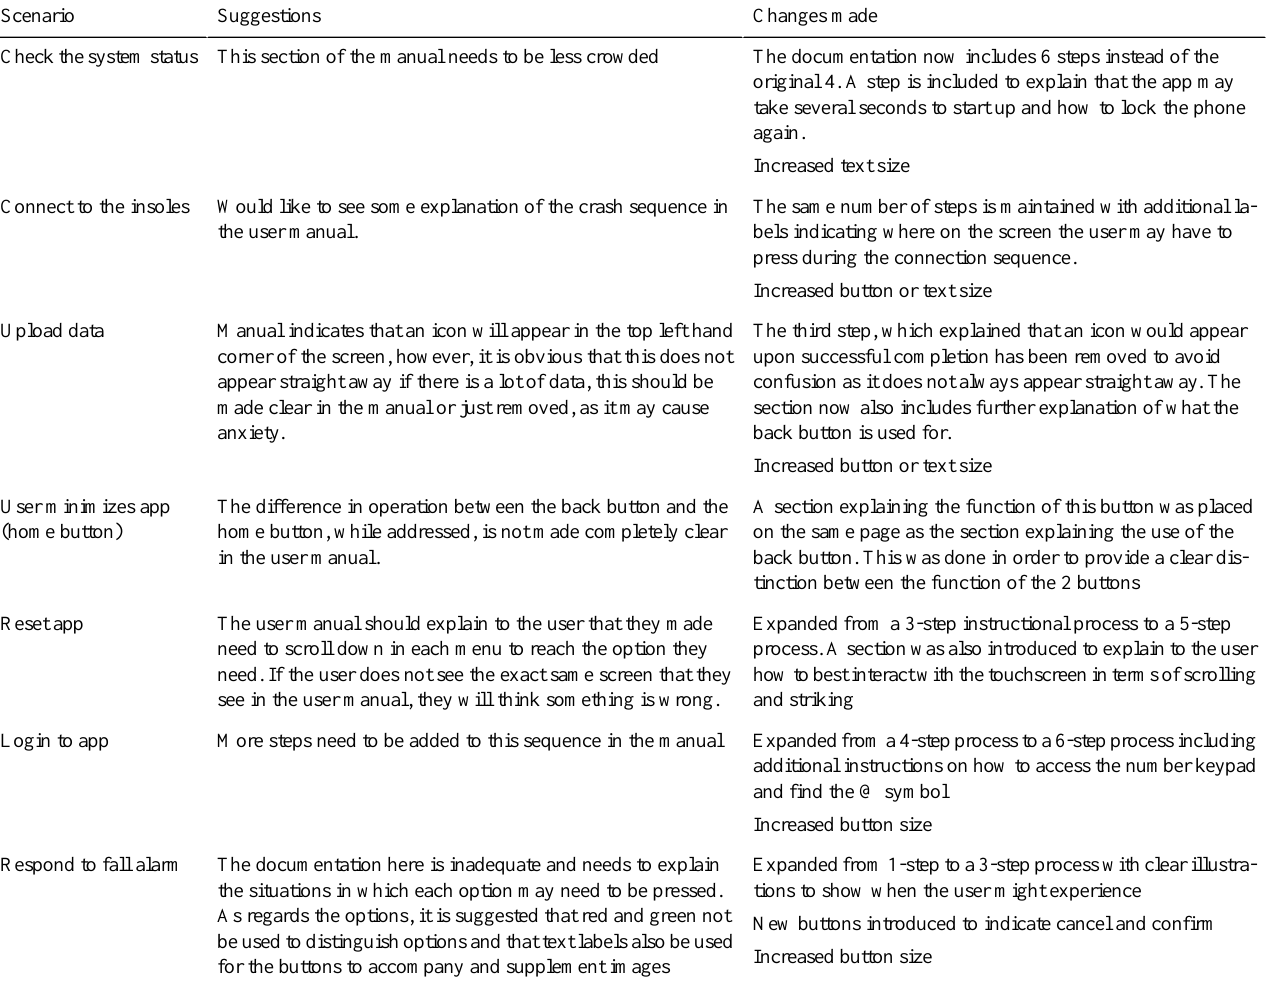
Table 12. Changes made to the user manuals and interface based on expert inspection.